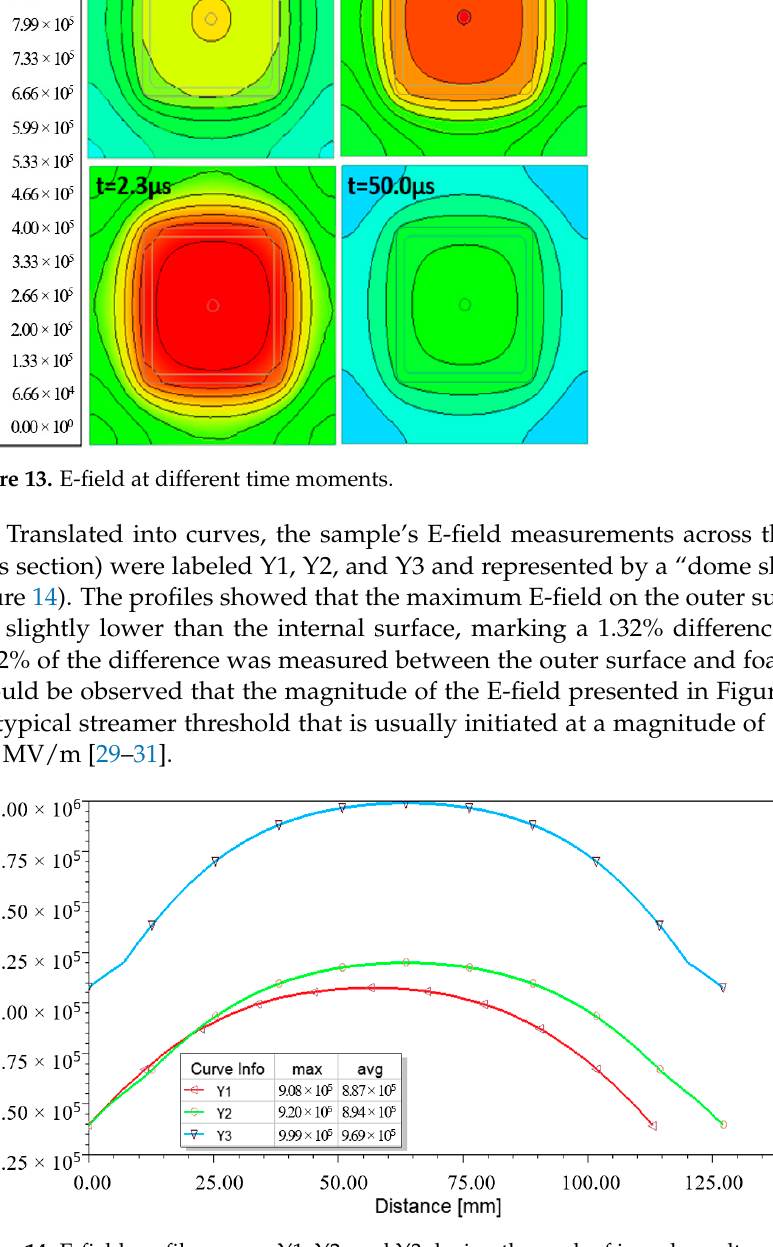
Figure 14. E-field profiles across Y1, Y2, and Y3 during the peak of impulse voltage. In general, the E-field intensity is closely associated with the voltage gradient across the insulating material. For example, the voltage distribution across X3 is presented in Figure 15. The voltage was non-linearly distributed across the distance where the gradient changes could be seen at 10 mm and 90 mm at which the interface of sealer and foam material existed.